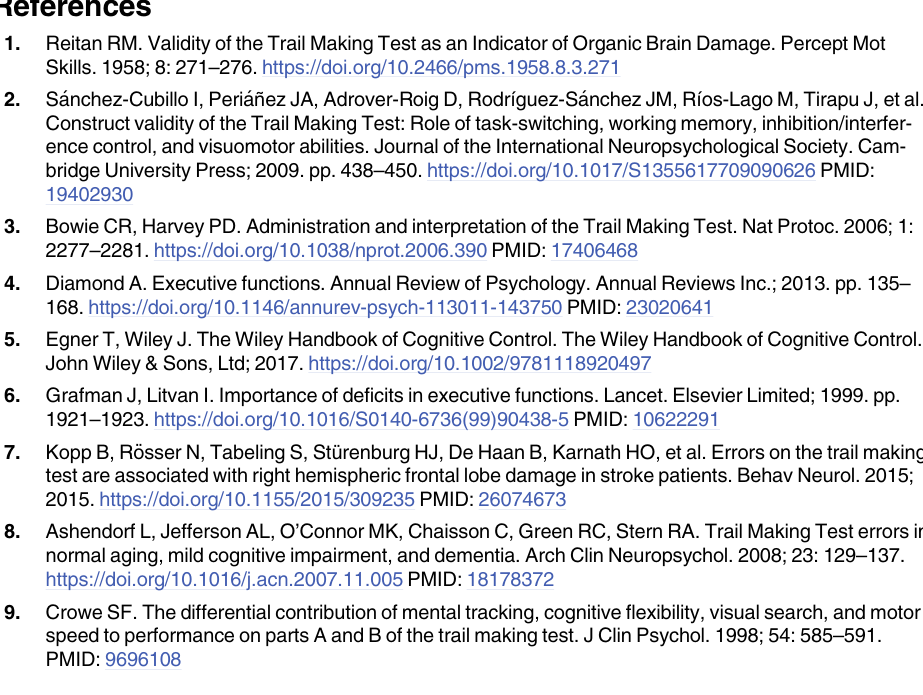
S1 Table. Descriptive results of dependent variables per experimental